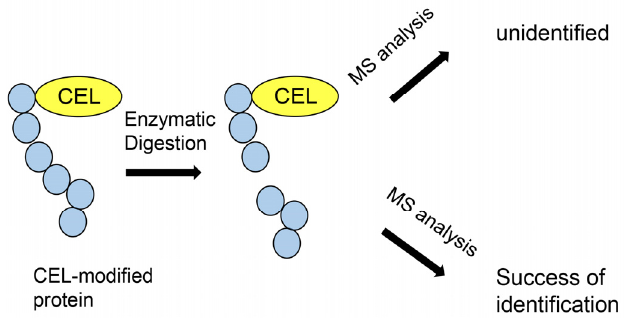
Figure 8. Model image of MALDI–MS or ESI–MS analysis of CEL-modified protein.